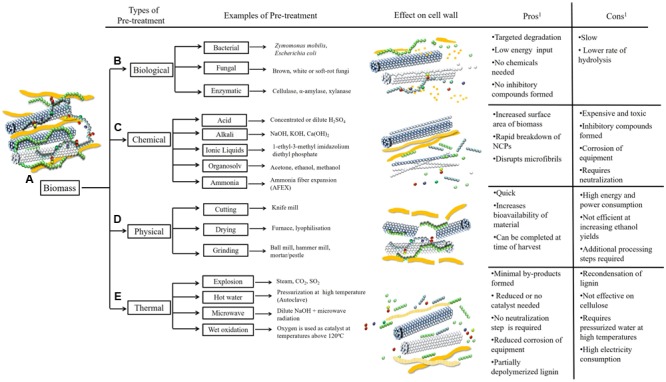
Selected pre-treatment methods differentially affect the breakdown and liberation of polymers from the cell wall. Lignocellulosic biomass is a complex network of carbohydrate and non-carbohydrate polymers (A). In its native form plant biomass is usually recalcitrant to conversion and fermentation processes. Pre-treatment is the initial processing step used to convert raw biomass into a form that can be more readily hydrolyzed. Biological pre-treatments are efficient at removing lignin from the network, leaving a carbohydrate-enriched fraction (B). Chemical pre-treatments may result in complete breakdown and fragmentation of cell wall components (C). Physical pre-treatments are used to reduce the particle size of the biomass (D). The use of thermal pre-treatments may loosen bonds between and within polymers but lignin is not completely removed (E)1 (Mosier et al., 2005; Kumar et al., 2009; Takara and Khanal, 2012).